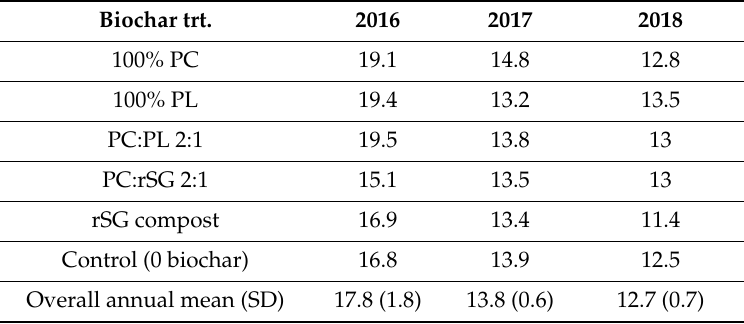
Table 7. Water use e ffi ciency determined for each treatment (units are kg dry corn grain per ha / mm of cumulative monthly precipitation recorded between April to August; PC = pine chip, PL = poultry litter, rSG = raw switchgrass compost; SD = standard deviation). Biochar